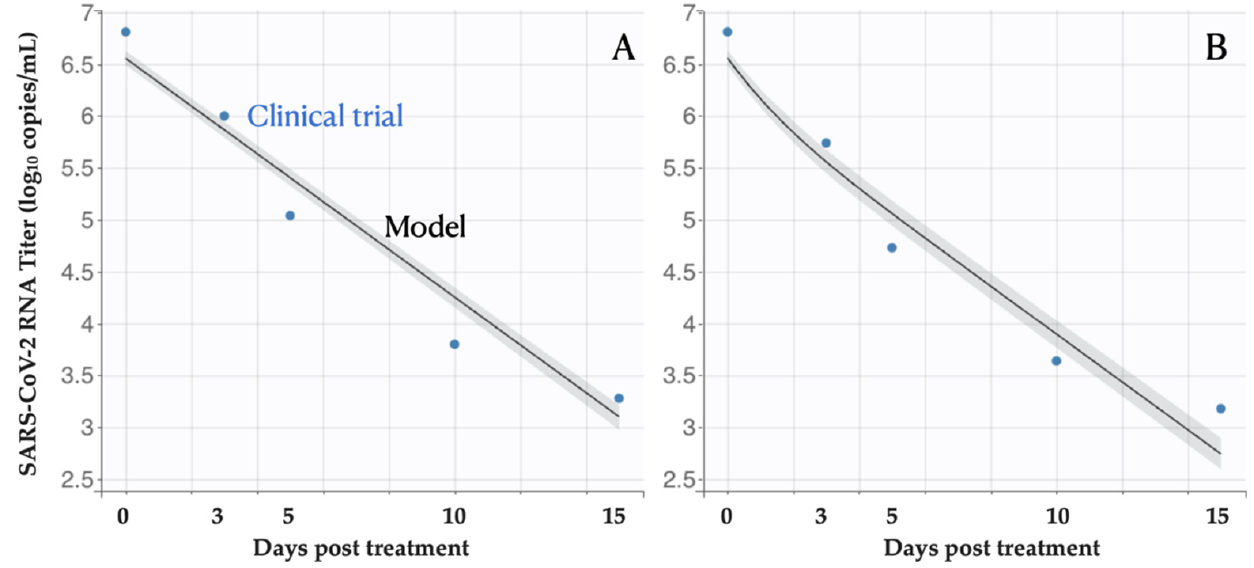
Figure 2. Viral load following Molnupiravir treatment. The estimated means and 95% CI of virus titer from the fitted within-host model track the mean values of empirical observations (blue circles) among patients treated with ( A ) placebo, or ( B ) Molnupiravir. Day zero corresponds to the beginning of the treatment.